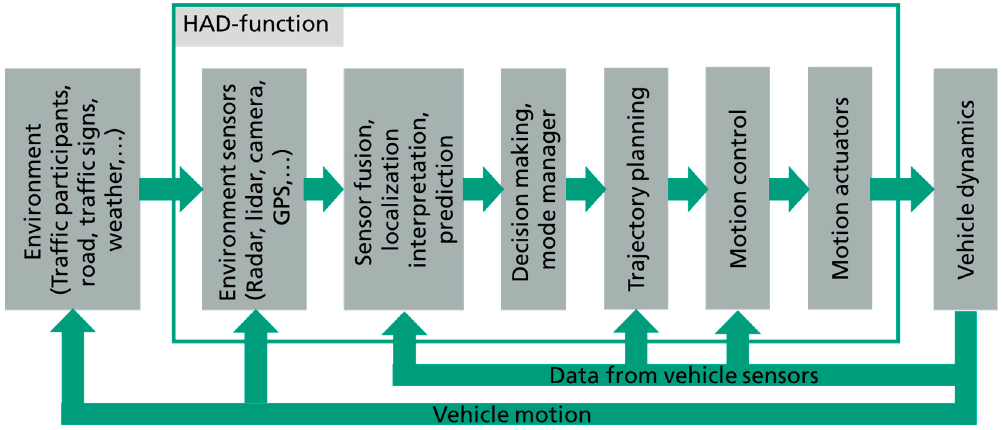
Figure 1. Flowchart for simulation of an autonomous vehicle.